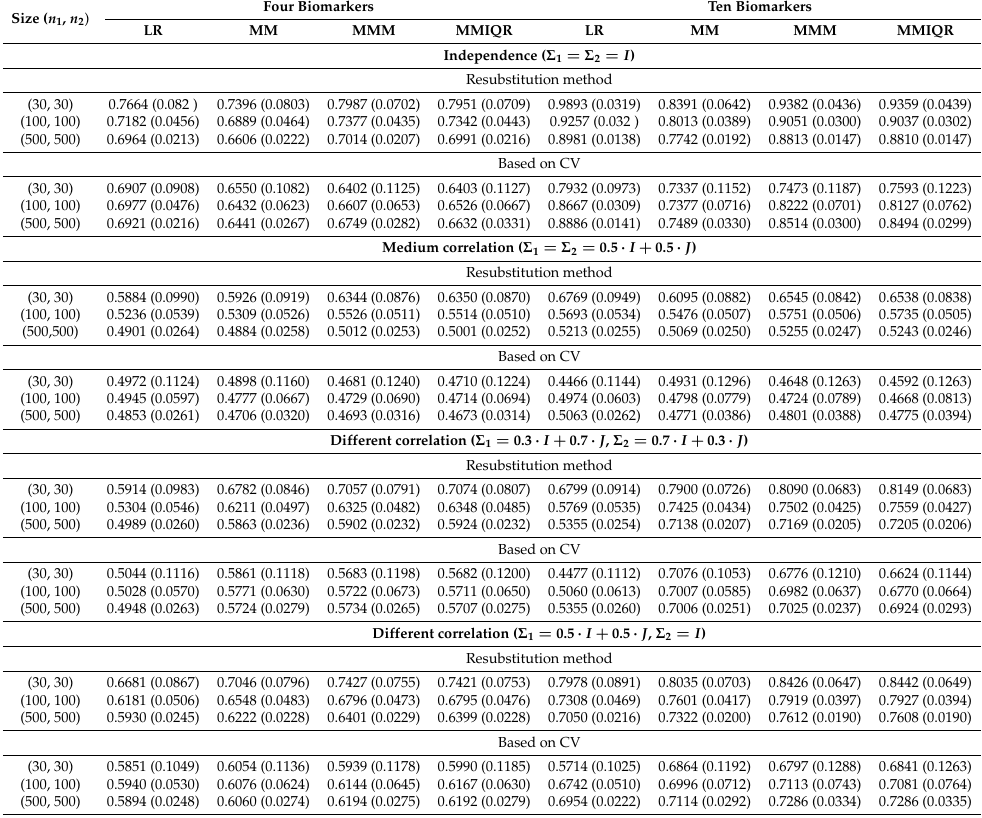
Table 2. Mean and standard deviation maximum Youden indices for 1000 random samples: normal distributions. Same means between